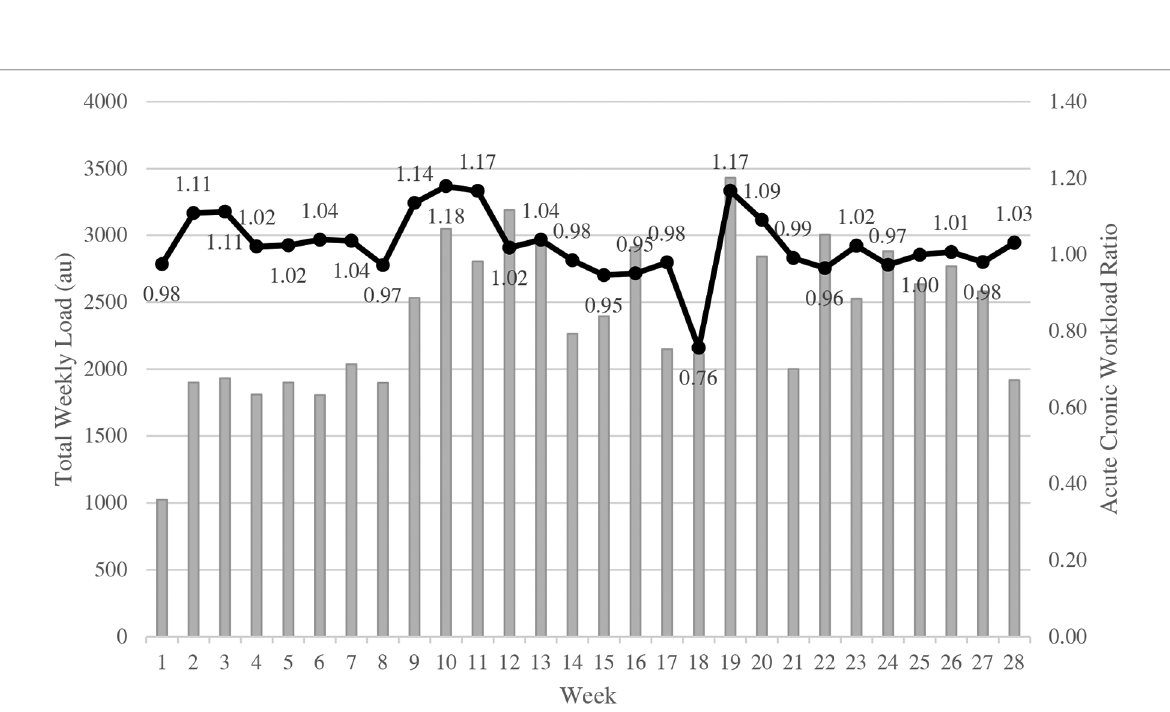
periods; (2) determining differences in PL, PL*min − 1 , High-IMA, and Jumps, respectively, for each time-period; and (3) establishing season-long weekly descriptive values for weekly PL totals, weekly percent change in PL, and ACWR.